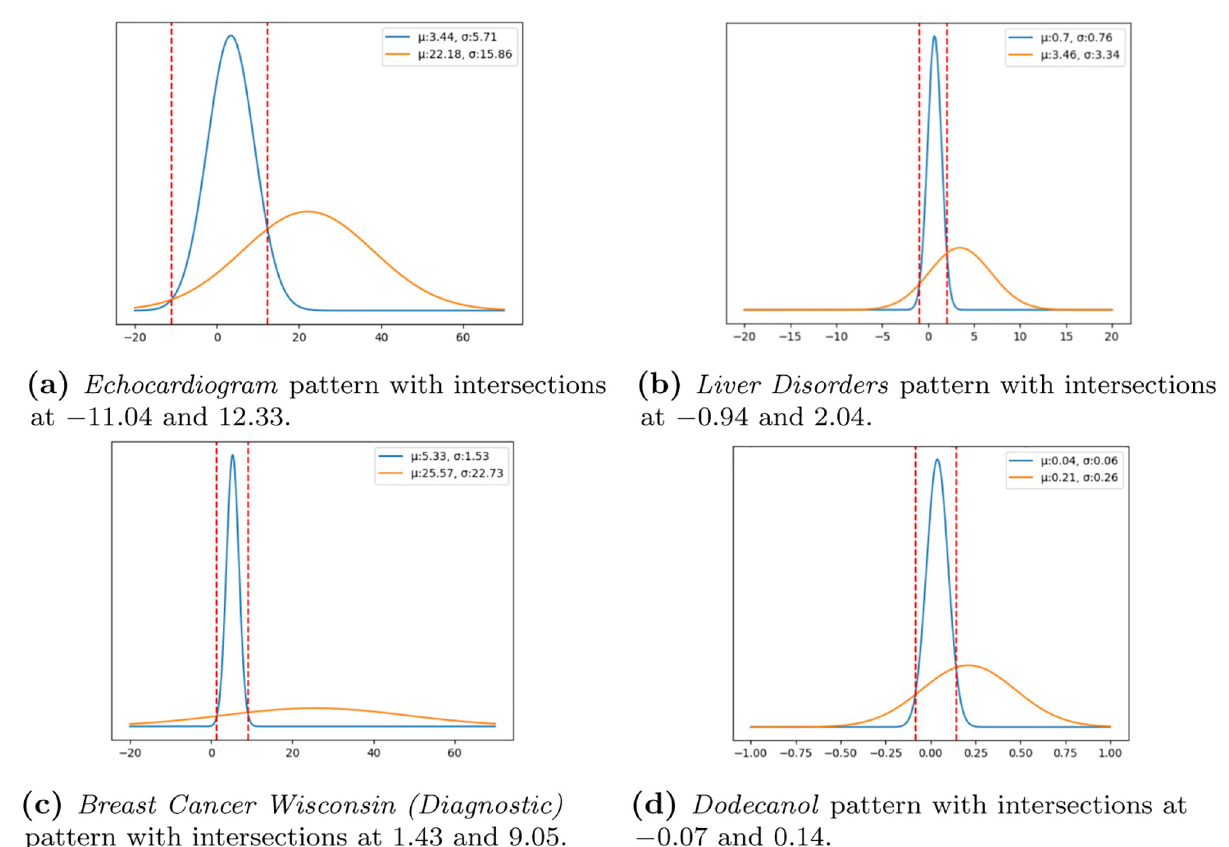
Fig 7. Visual characterization of the discriminated range of outcomes per pattern. Each chart displays the Gaussian intersections between the outcome variable and the distribution of pattern-conditional outcomes. The blue line represents the Gaussian of the pattern outcome space, orange line represents the Gaussian of the original outcome space. All patterns displayed above have | L | = 7 categories (very low, low, medium-low, medium, medium-high, high, very high). Patterns: (a) φ = {medium contractility (epss), medium size of the heart at end-diastole (lvdd)}; (b) φ J A high values of alkaline phosphotase (alkphos), very-high values of alanine aminotransferase (sgpt), very-high values of gamma-glutamyl transpeptidase = {high standard deviation among the cells compactness, very high compactness, very high severity of concave portions of the (gammagt)}; (c) φ J C contour, very high symmetry}; (d) φ = {very high values of A1U2T0, low values of A1U3L3}. (a) Echocardiogram pattern with intersections at − 11.04 J D and 12.33. (b) Liver Disorders pattern with intersections at − 0.94 and 2.04. (c) Breast Cancer Wisconsin (Diagnostic) pattern with intersections at 1.43 and 9.05. (d) Dodecanol pattern with intersections at − 0.07 and